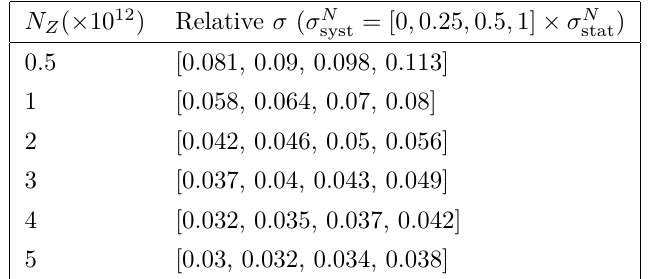
Table 3 . Estimated relative precision on N ( B + levels of systematic uncertainty on the signal yield are shown.